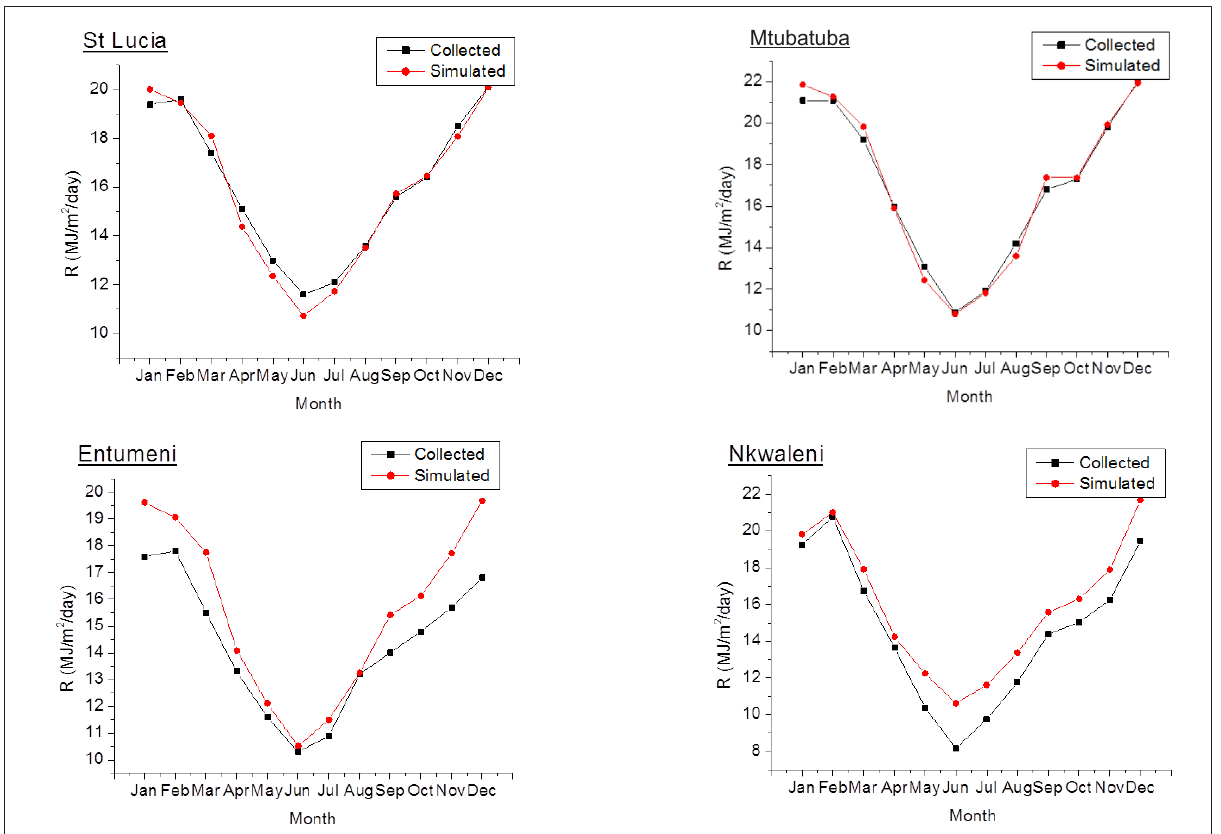
Figure 3: Testing the Heatonville/Empangeni model using four other stations in the studied